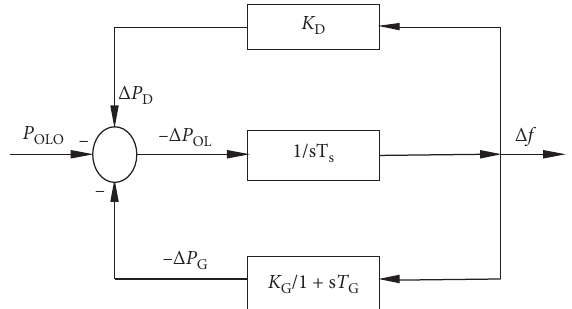
Figure 2: Block diagram of frequency response model of an equivalent single machine with load.